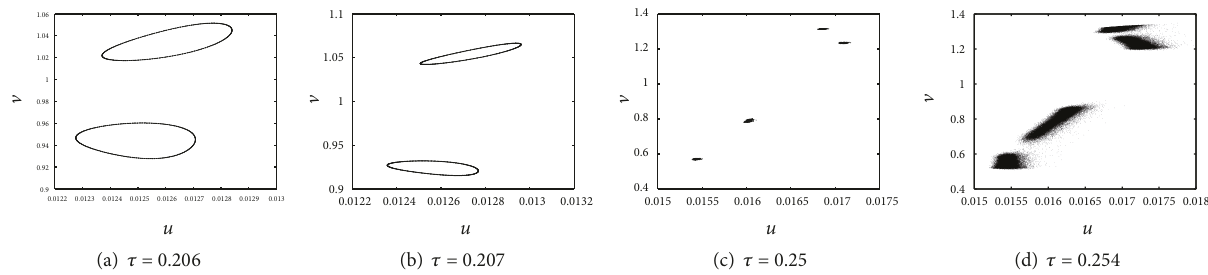
Figure 10: Phase diagrams corresponding to Figure 9(c), demonstrating the predator-prey dynamics of the coupled network. (a)-(c) are plotted with the (𝑢, V ) states at one